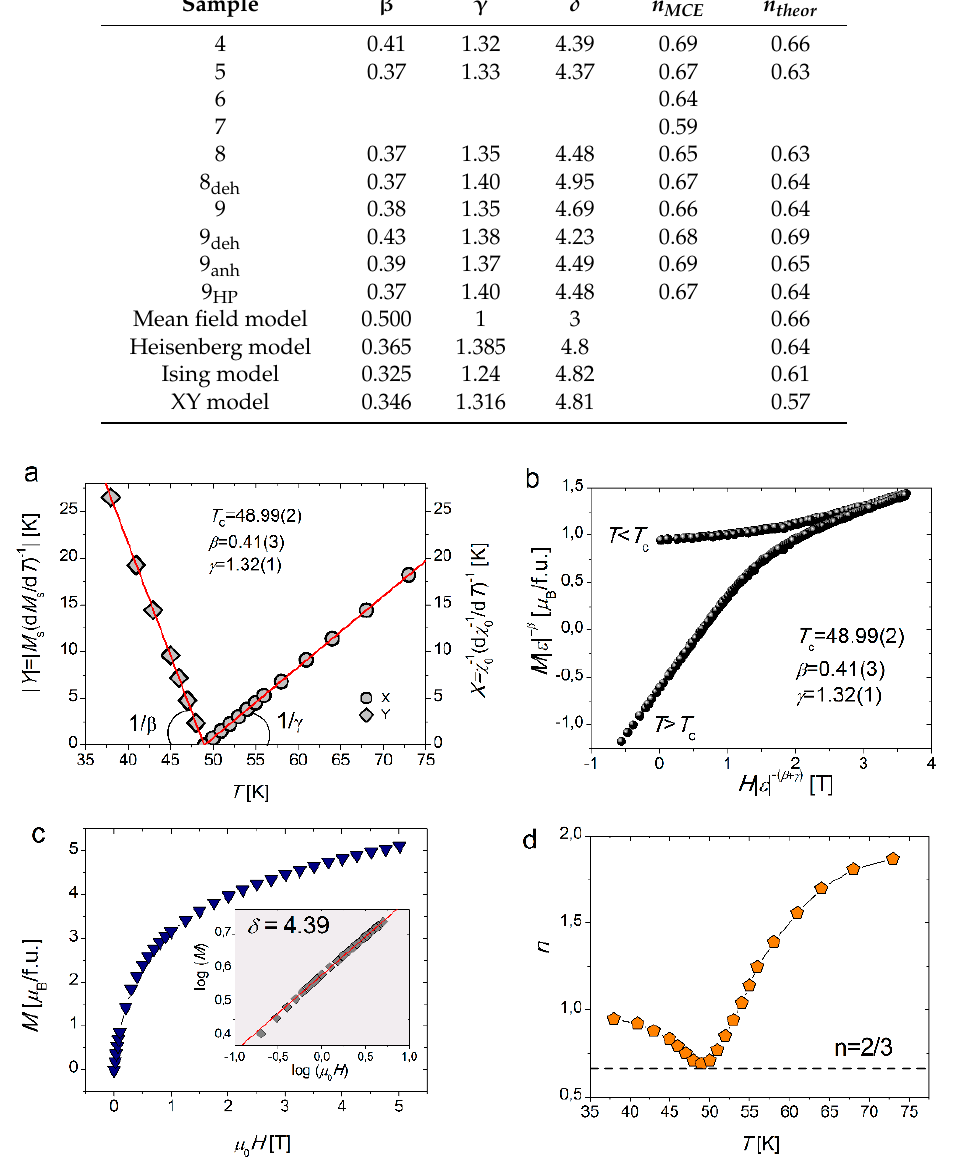
Figure 27. ( a ) Determination of the critical exponents and the critical temperature for 4 using the Kouvel–Fisher method, ( b ) logarithmic scaling plot of M | ε | − β vs. H · | ε | − ( β + γ ) for 4 evidences the validity Kouvel–Fisher method, ( c ) magnetization vs. magnetic field measured for M ( H ) obtained for 4 at temperature T = 49 K; inset shows the same M ( H ) plots in the log–log scale, which was used for determination of critical exponent δ , ( d ) temperature dependence of exponent n obtained for 4 .